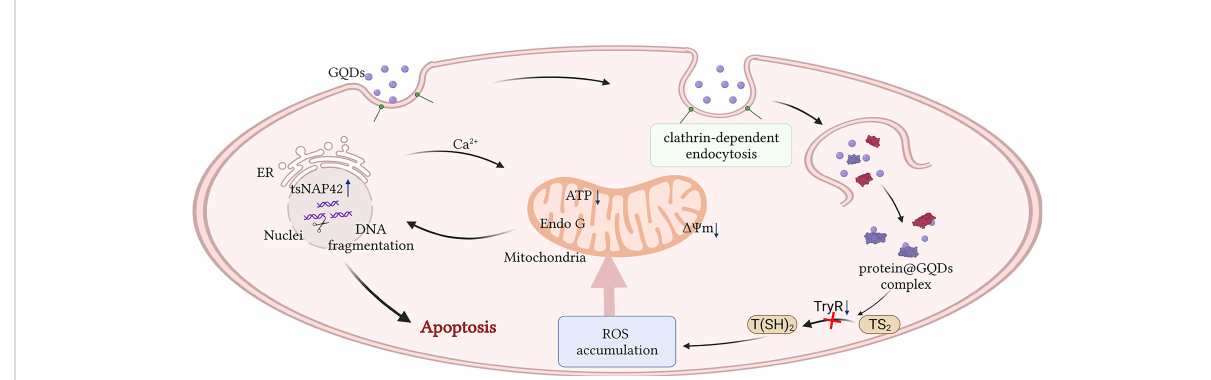
FIGURE 7 Schematic description of the apoptotic process caused by graphene quantum dots (GQDs) in Trypanosoma brucei . GQDs were internalized by T. brucei through clathrin-mediated endocytosis and interacted with several proteins, including trypanothione reductase (TryR), a key enzyme responsible for catalyzing trypanothione disul fi de (TS 2 ) to trypanothione [T(SH) 2 ] in the anti-oxidation of trypanosome. The reduced TryR activity resulted in the accumulation of intracellular reactive oxygen species (ROS), eventually inducing apoptosis via mitochondrial and endoplasmic reticulum (ER) stress pathways. This fi gure was created by biorender. The agreement number is